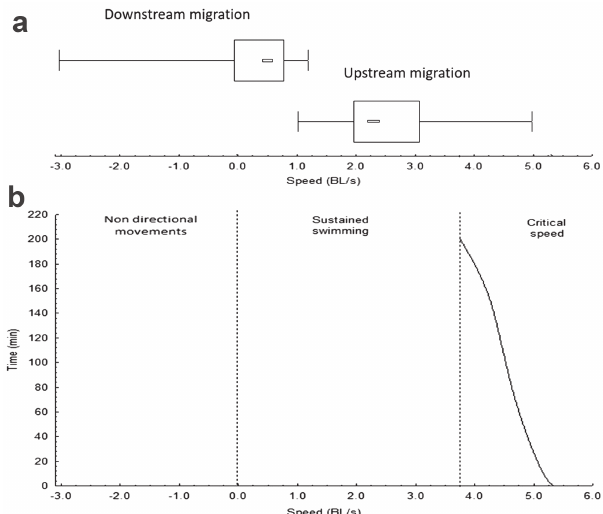
Fig. 6. Prochilodus costatus swimming speeds measured a. in this study in stretch 2 and b. in the laboratory by Santos et al . (2012). Central points are medians, boxes represent percentiles 25 and 75 and whiskers represent amplitude. Dashed lines separate different kinds of fi sh movements. BL/s = swimming velocity in standard length of fi sh per